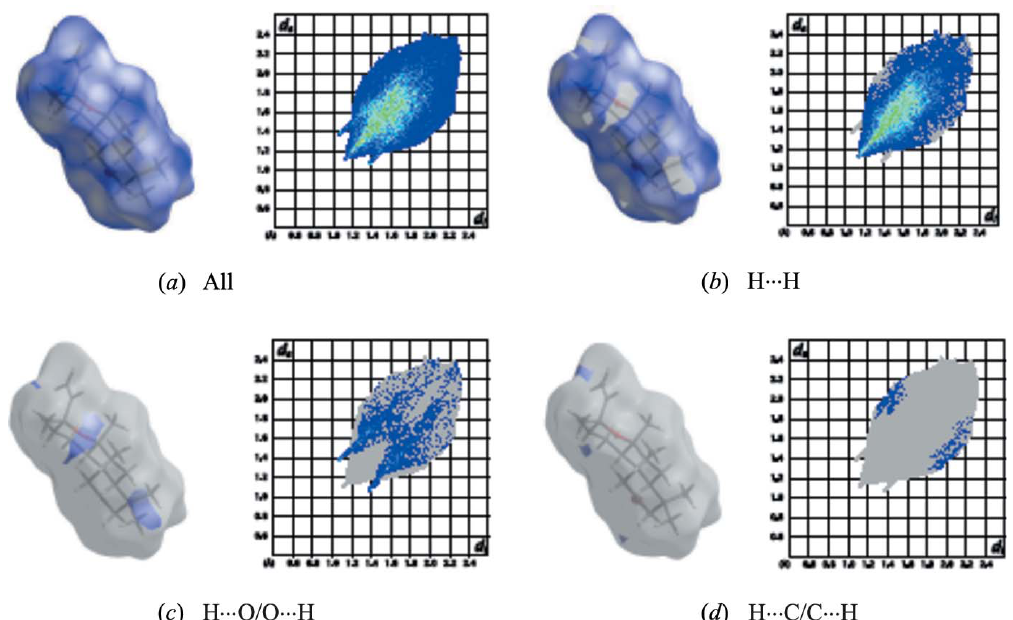
Figure 4 The two-dimensional fingerprint plots of the title compound, showing ( a ) all interactions, and delineated into ( b ) H (cid:2)(cid:2)(cid:2) H, ( c ) H (cid:2)(cid:2)(cid:2) O and ( d ) H (cid:2)(cid:2)(cid:2) C interactions [ d e and d i represent the distances from a point on the Hirshfeld surface to the nearest atoms outside (external) and inside (internal) the surface,